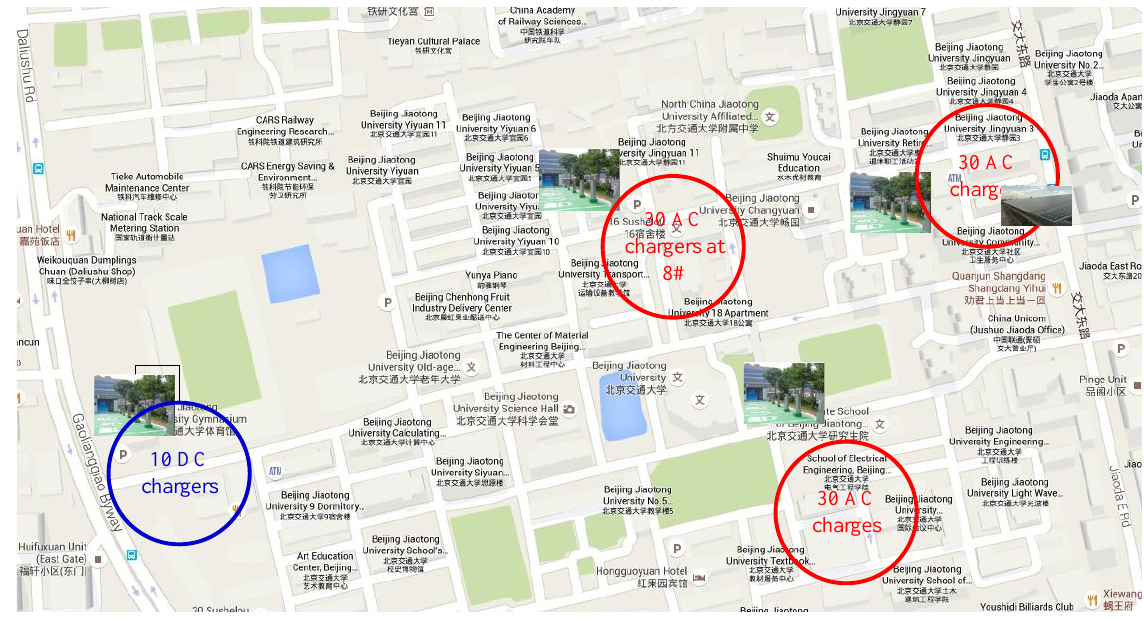
Figure 3. Geographical placement of EV chargers.